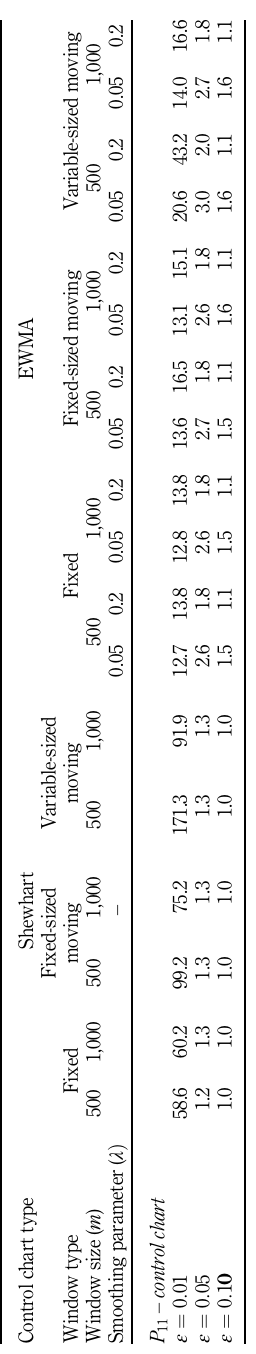
Table 4. Out-of-control AARL values for the Shewhart and EWMA control charts when m 5 500 and 1,000 networks assuming fixed, fixed-sized moving and variable- sized moving windows for simulation case